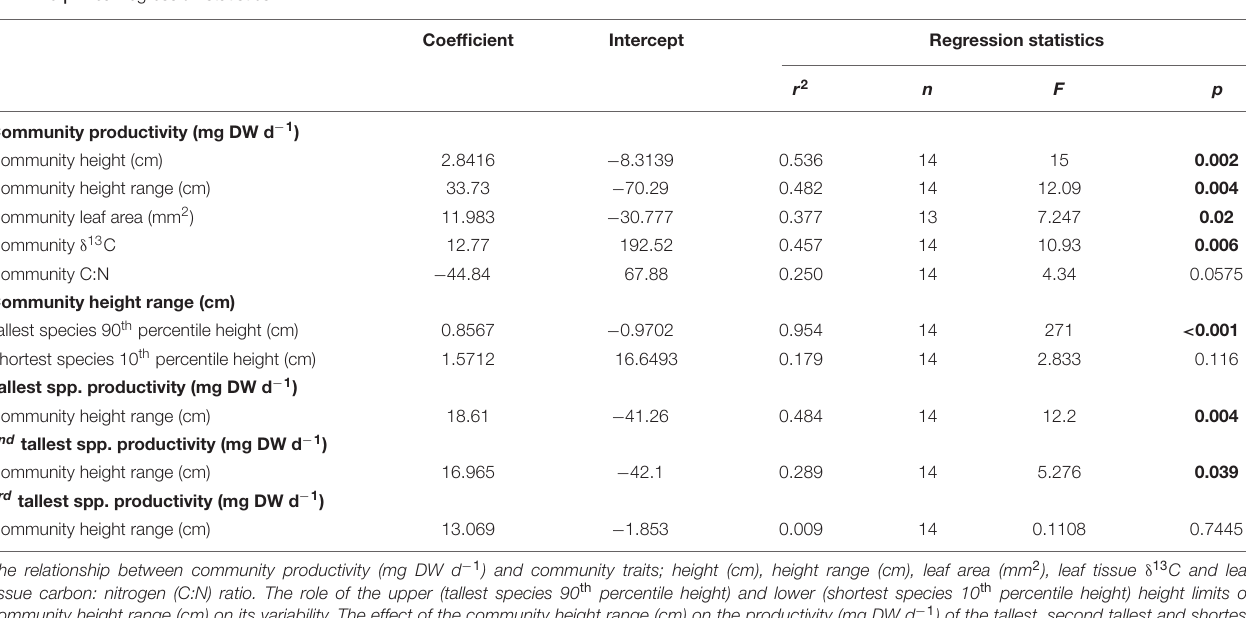
TABLE 3 | Linear regression